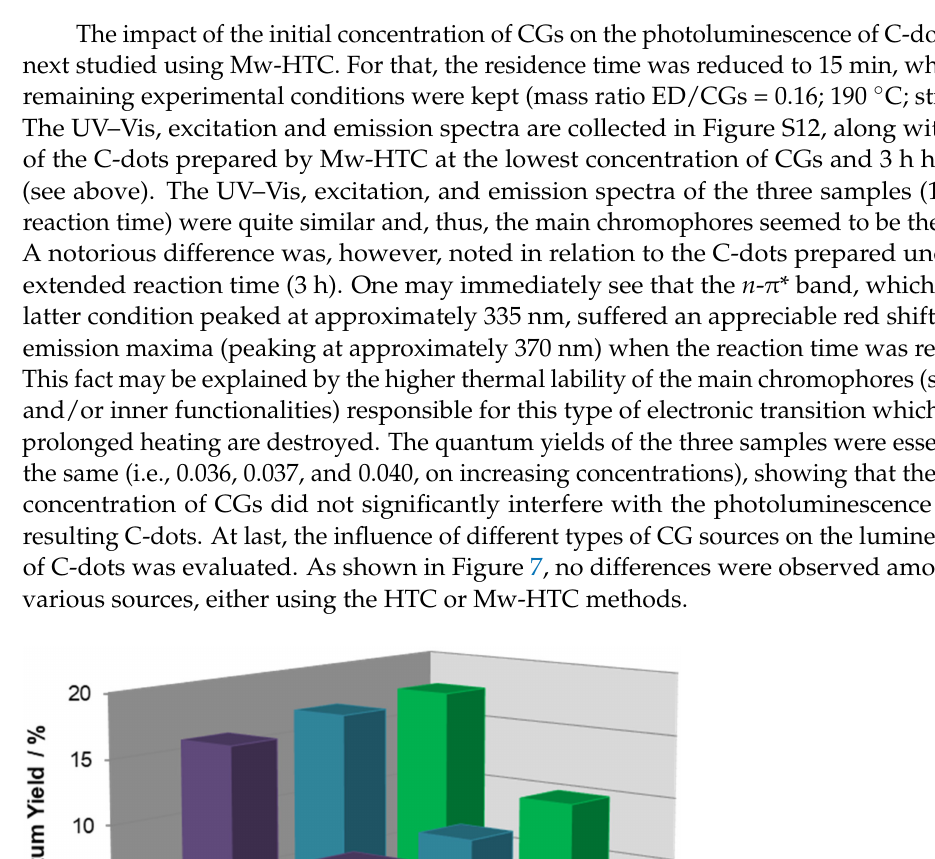
Figure 6. Comparative chart of the photoluminescence of C-dots prepared under the HTC and Mw-HTC methods using various additives (HTC: 250 ◦ C, 6 h; Mw-HTC: 190 ◦ C, 3 h; mass ratio amine/CGs = 0.16).